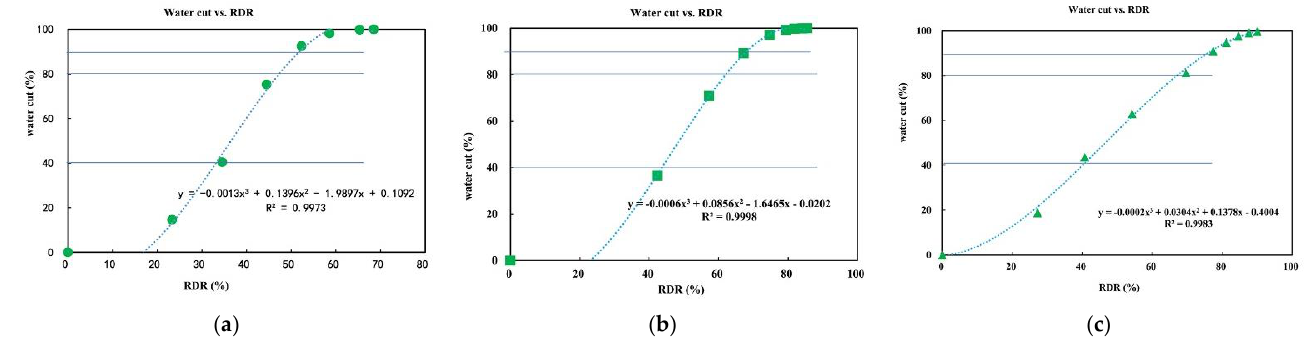
Figure 10. Relationship between resistivity decline rate (RDR) and water production rate of classified reservoirs. ( a ) Class I reservoirs, ( b ) Class II reservoirs, and ( c ) Class III reservoirs.